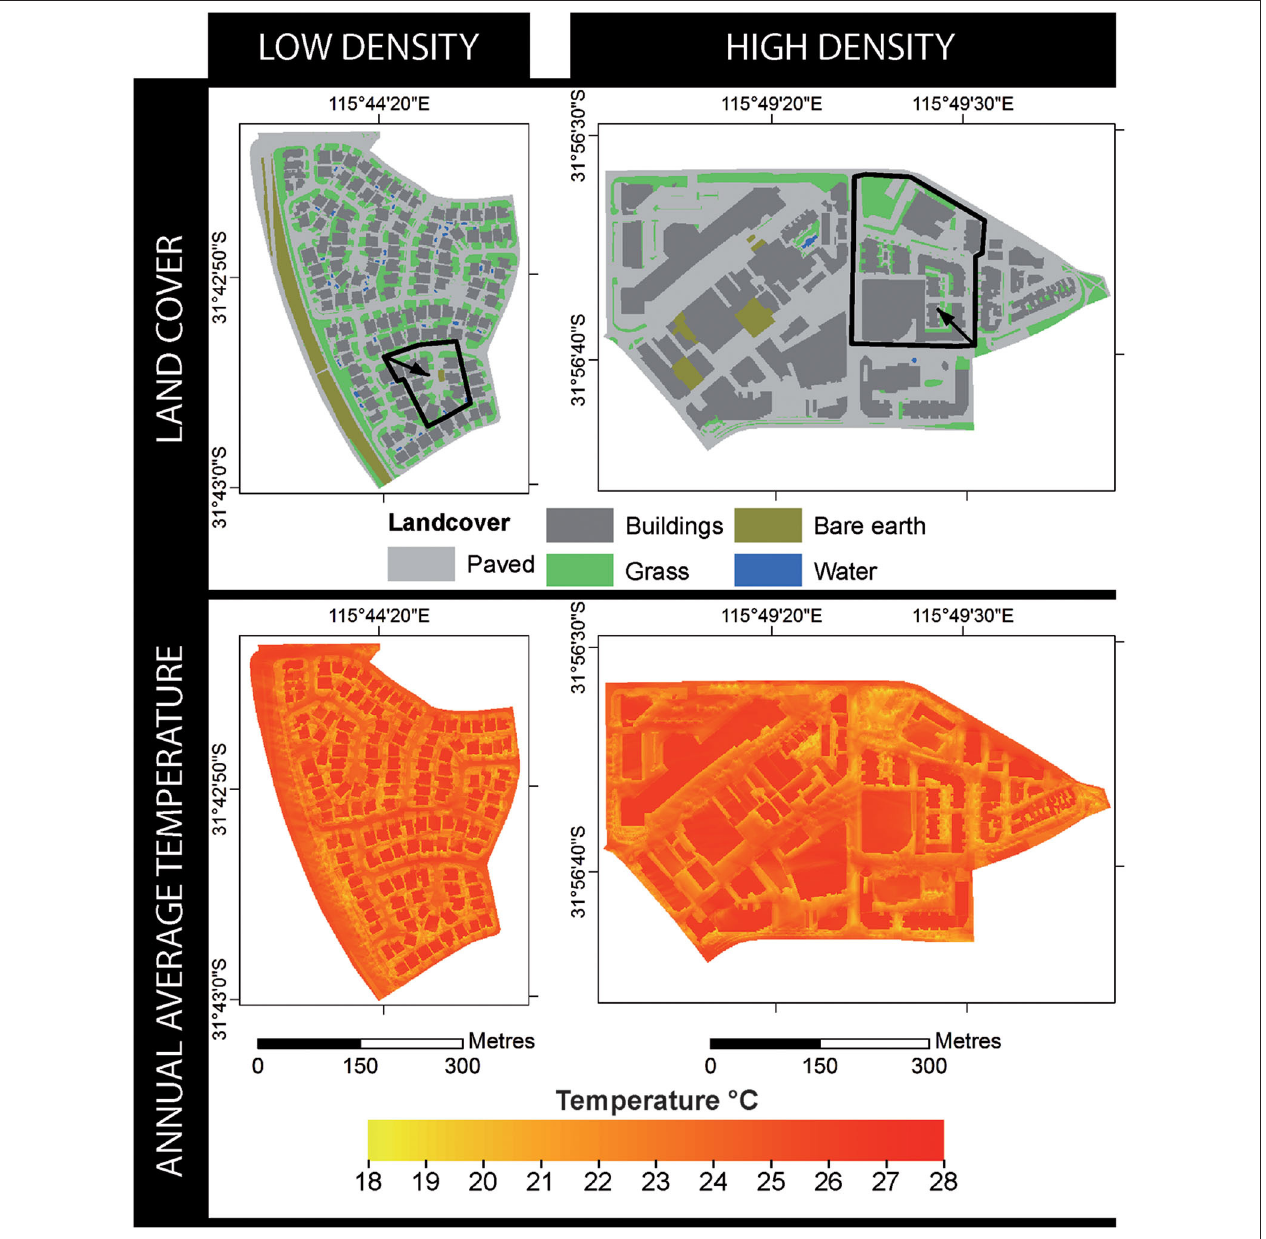
FIGURE 3 | Land cover (top row) and average annual mean radiant temperature ( T mrt ) overlays (bottom row) for two SA1s as defined by the ABS representing low (Currambine, SA Level 1 ID: 5107102) and high (Subiaco, SA Level 1 ID: 5104203) density developments. Bold black outline extents with directional arrows denote three-dimensional subsets presented in Figure 2